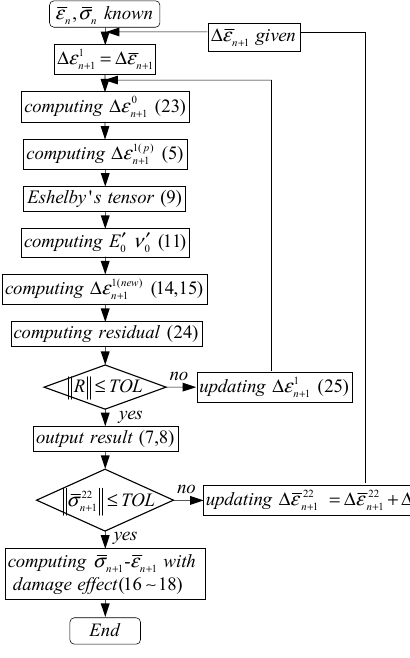
Figure 1. Flow chart of numerical integration algorithm under displacement-based loading.